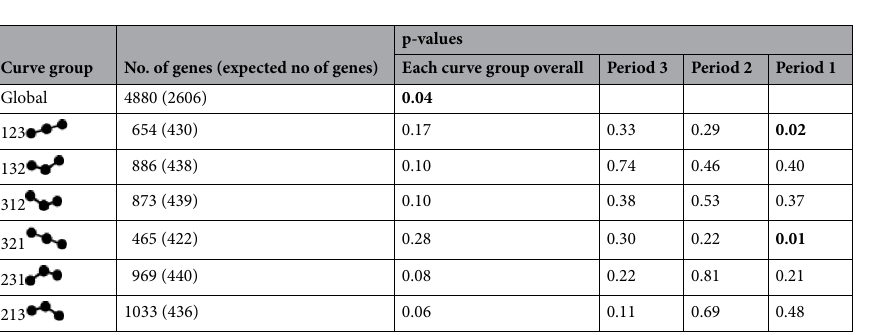
Table 4. The number of genes identified in curve groups for metastatic cases (n = 33, 31, 36 in the three time windows, respectively) and the associated p-values for testing curve groups overall and for each curve group separately in each time window. Period 1 is closest to diagnosis and the number listed first is the respective period with the highest mean. In the dots provided for illustration, diagnosis is to the right. Bold values indicate values below